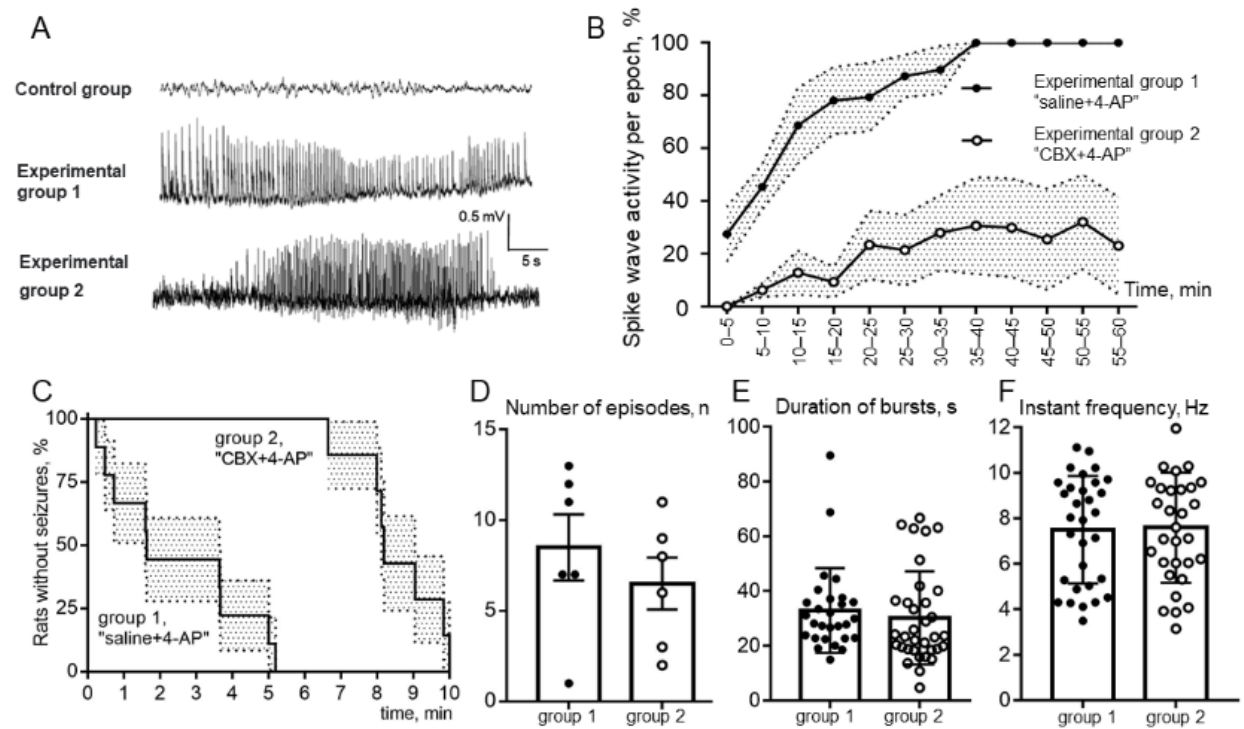
Figure 3. ( A ). Examples of a ECoG records; control group, no spike-wave activity (SWA) after only CBX or saline intracortical injection; group 1, ECoG of status epilepticus in a rat that received 4-AP after saline injection; group 2, seizure of epileptiform spike-wave activity on an ECoG of a rat that received 4-AP after CBX injection. ( B ). Comparison of the total duration of episodes of SWA over the epoch of analysis; ( C ). Percentage of animals of experimental groups 1 and 2 without seizure free during 10 min above 4-AP injection (latency to first SWA episode); ( D ). Comparison of the number of SWA episodes; ( E ). The mean values of the duration of bursts; ( F ). Comparison of instantaneous repetition rate in the composition of SWA episodes in rats receiving 4-AP after saline (group 1, “saline + 4-AP”) and in rats receiving 4-AP after administration of CBX (group 2, “CBX + 4-AP”). The abscissa shows the time in minutes. The mean values and errors of the mean are given, and the reliability of the differences was determined by two-way ANOVA, p < 0.0001 ( B ); The log-rank (Mantel – Cox) test, p < 0.0001 ( C ); the means ± SD, unpaired Mann – Whitney test, p > 0.05 ( D – F ).